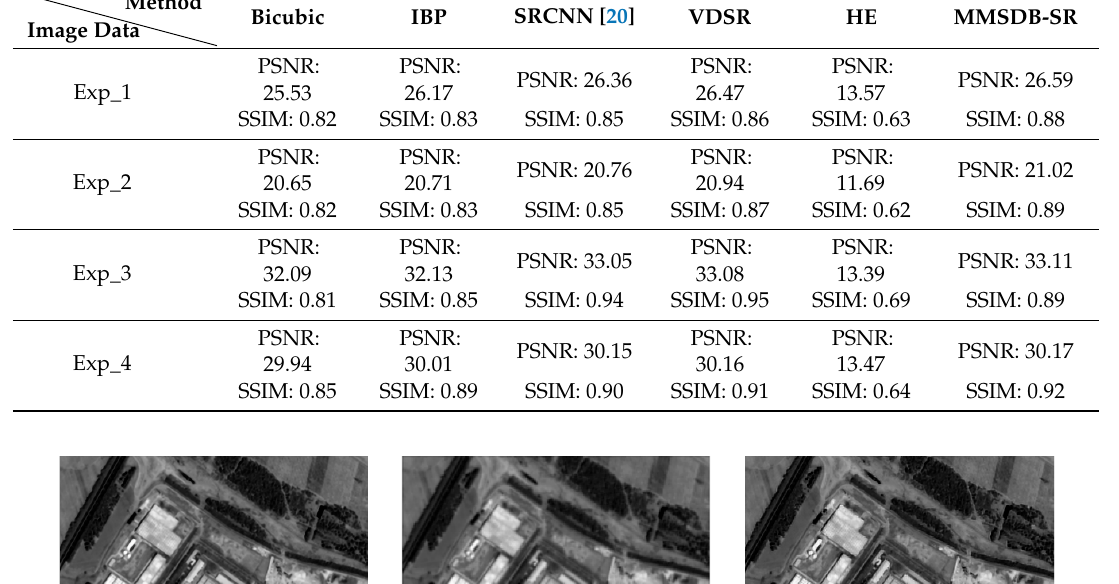
Table 2. The objective evaluation index results with random noise, with the range of [ − 2,2]. DataMethod Image